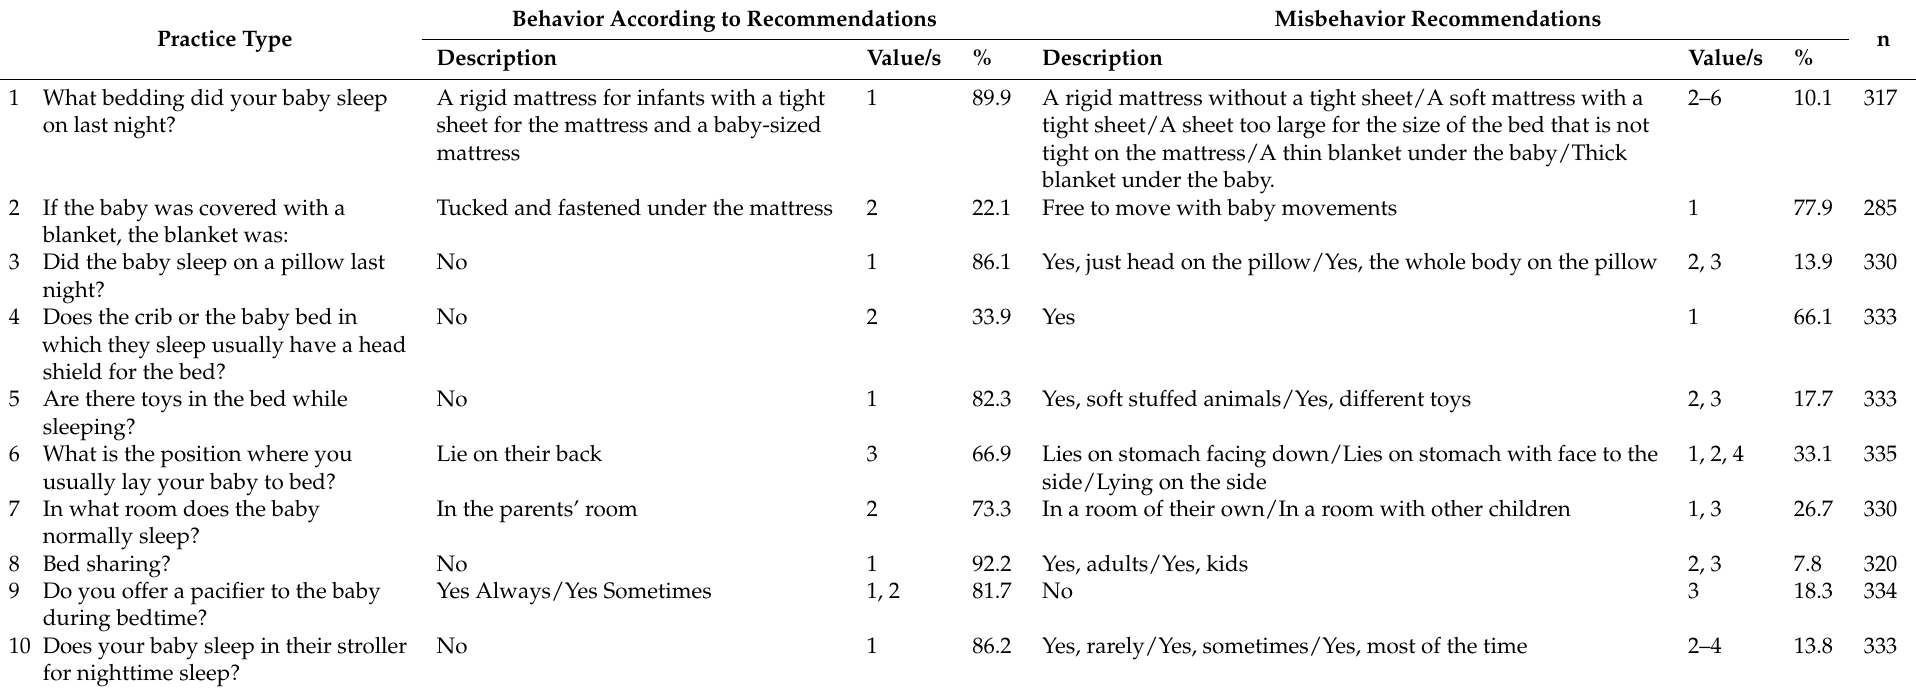
Table 4. Distribution of parental practice considering recommendation for baby’s safe